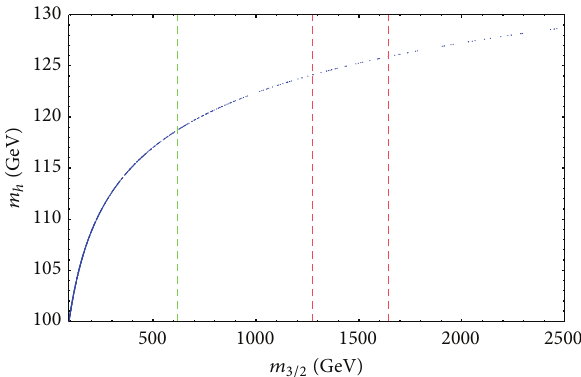
Figure 5: Higgs mass 𝑚 ℎ as a function of the gravitino mass 𝑚 3/2 . The region in left to the green line is disallowed by the gluino mass constraint, while the area between the red lines shows the region for which the Higgs mass lies in the range of 124 – 126